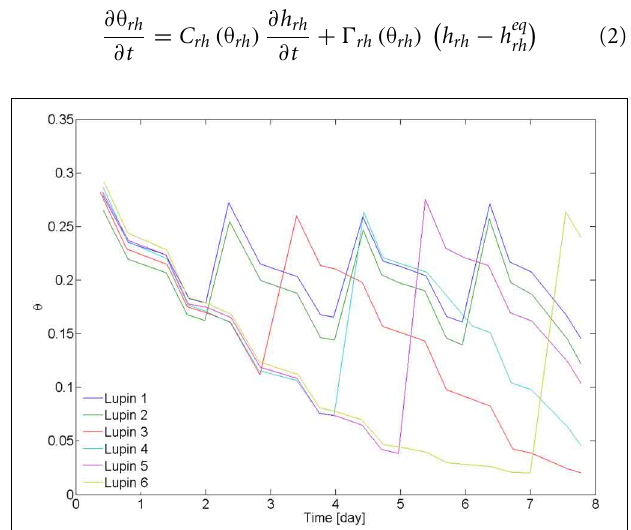
FIGURE 2 | Average water content in the samples. Lupin 1 and 2 were irrigated from the bottom every 2nd day. Lupin 3–6 were irrigated once after a drying period of increasing duration. Water content was measured by weighing the samples. The decrease of water content became slower as the soil became dry, showing a decrease of transpiration. The samples were irrigated by capillary rise from the bottom, setting a water table at 5cm above the bottom of the